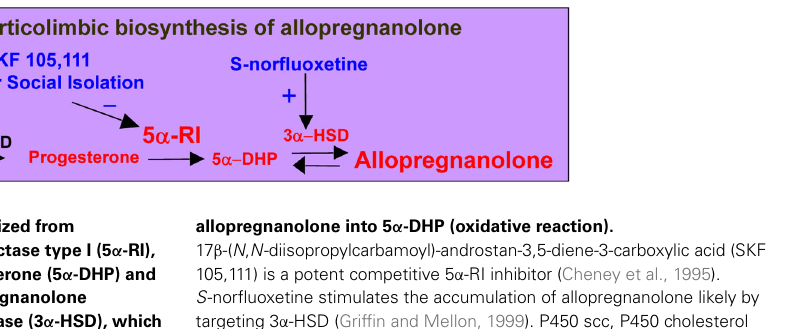
FIGURE 1 | In the brain, allopregnanolone is synthesized from progesterone by the sequential action of: (i) 5 α -reductase type I (5 α -RI), which reduces progesterone into 5 α -dihydroprogesterone (5 α -DHP) and functions as the rate-limiting step enzyme in allopregnanolone biosynthesis; and (ii) 3 α -hydroxysteroid dehydrogenase (3 α -HSD), which either converts 5 α -DHP into allopregnanolone (reductive reaction) or